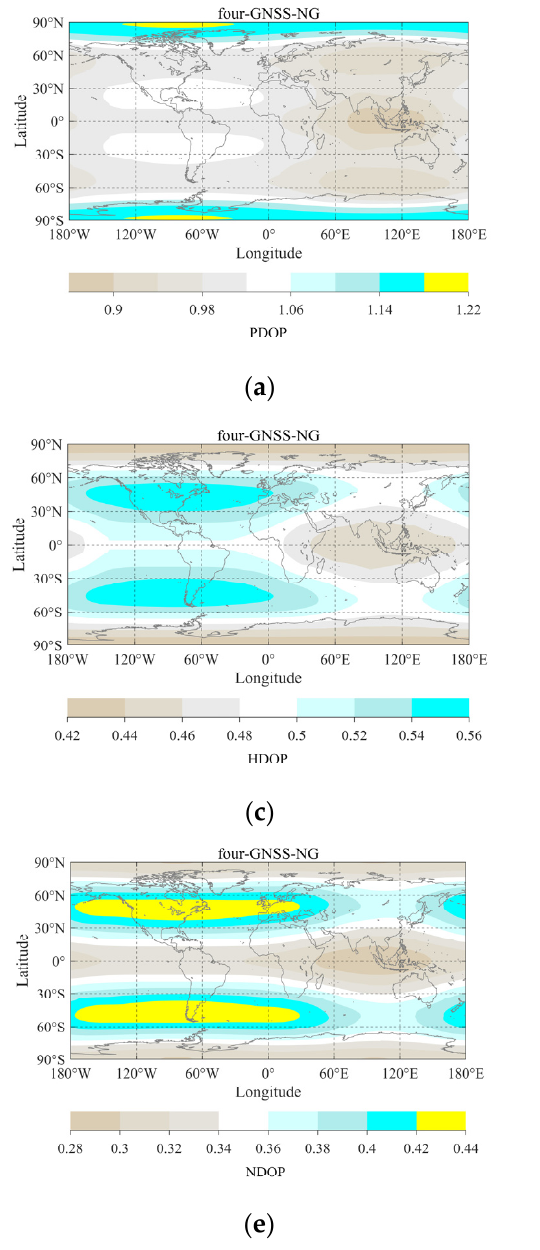
Table 4. Orbital configurations of the designed LEO constellations. Scheme